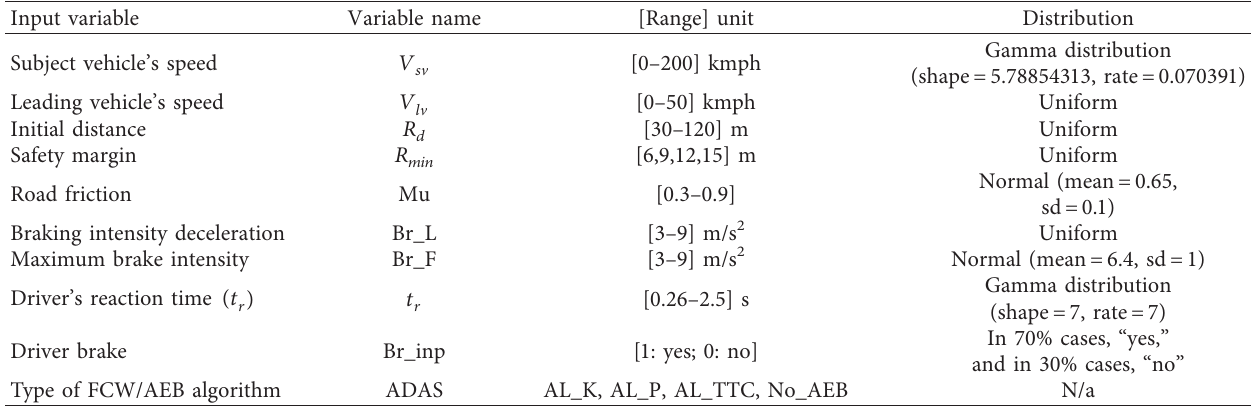
Table 4: Input parameters and their distribution.